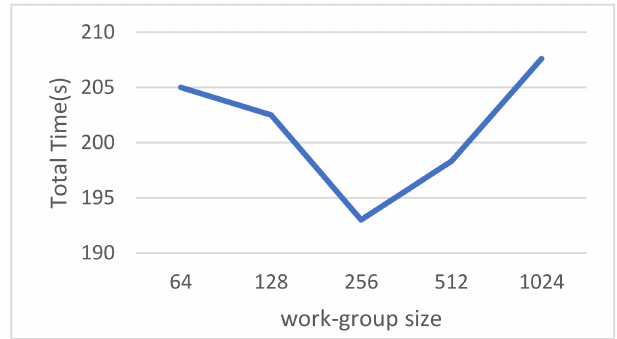
Figure 8. Tests for different workgroup